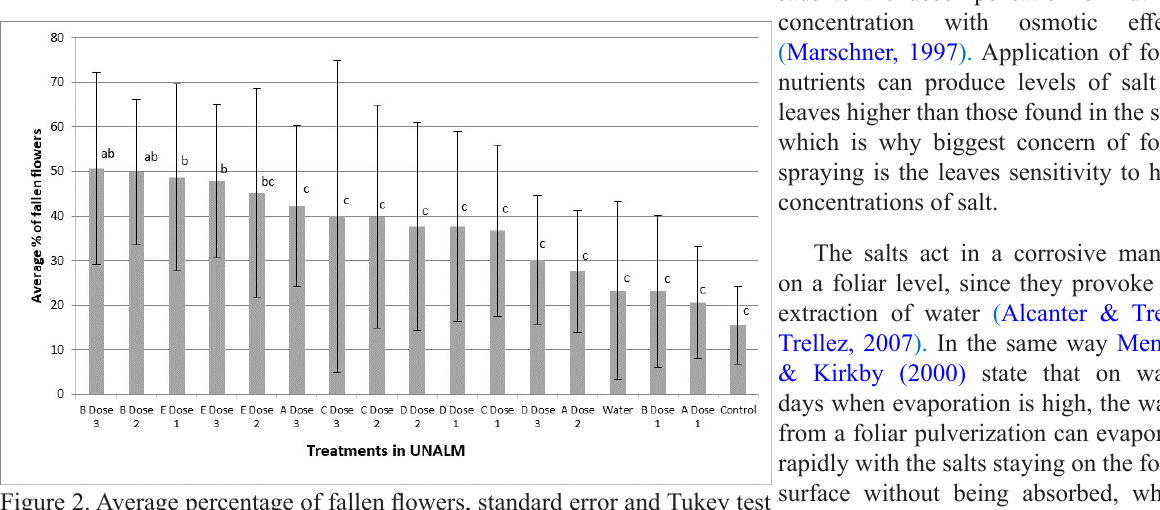
Figure 2. Average percentage of fallen flowers, standard error and Tukey test for the different treatments. Virú. La Libertad. Perú, May- June. 2008. etc.), the solution used (concentration, pH, synergistic or antagonistic, hygroscopicity, dose, etc.) and environmental conditions (temperature, light, humidity, luminosity,